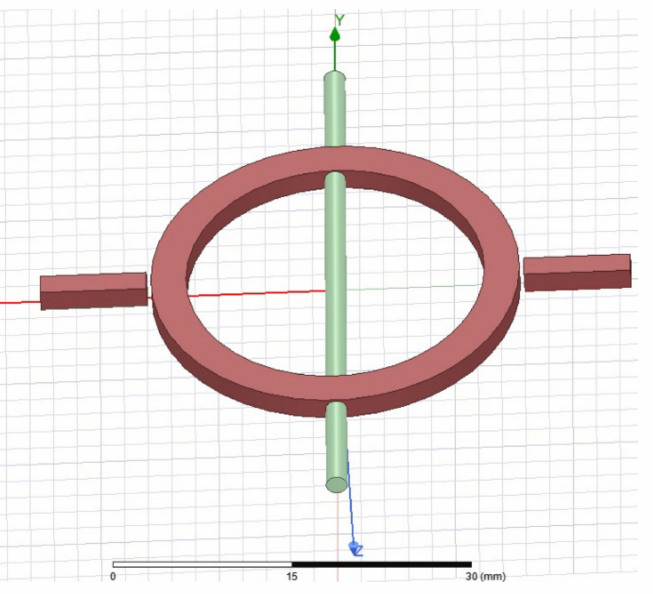
Figure 4. Overall geometry of the microwave resonator